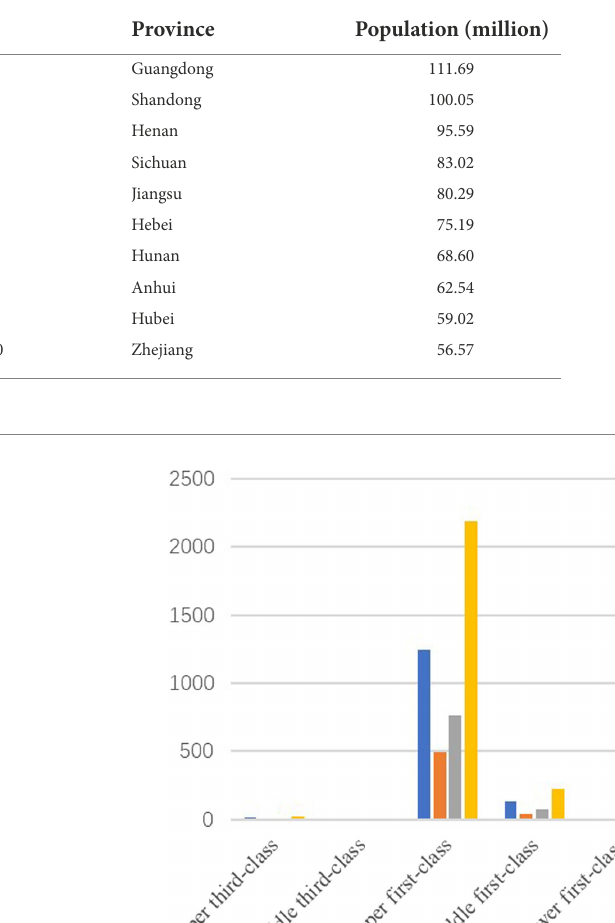
TABLE 3 The top 10 provinces in population, 2018.